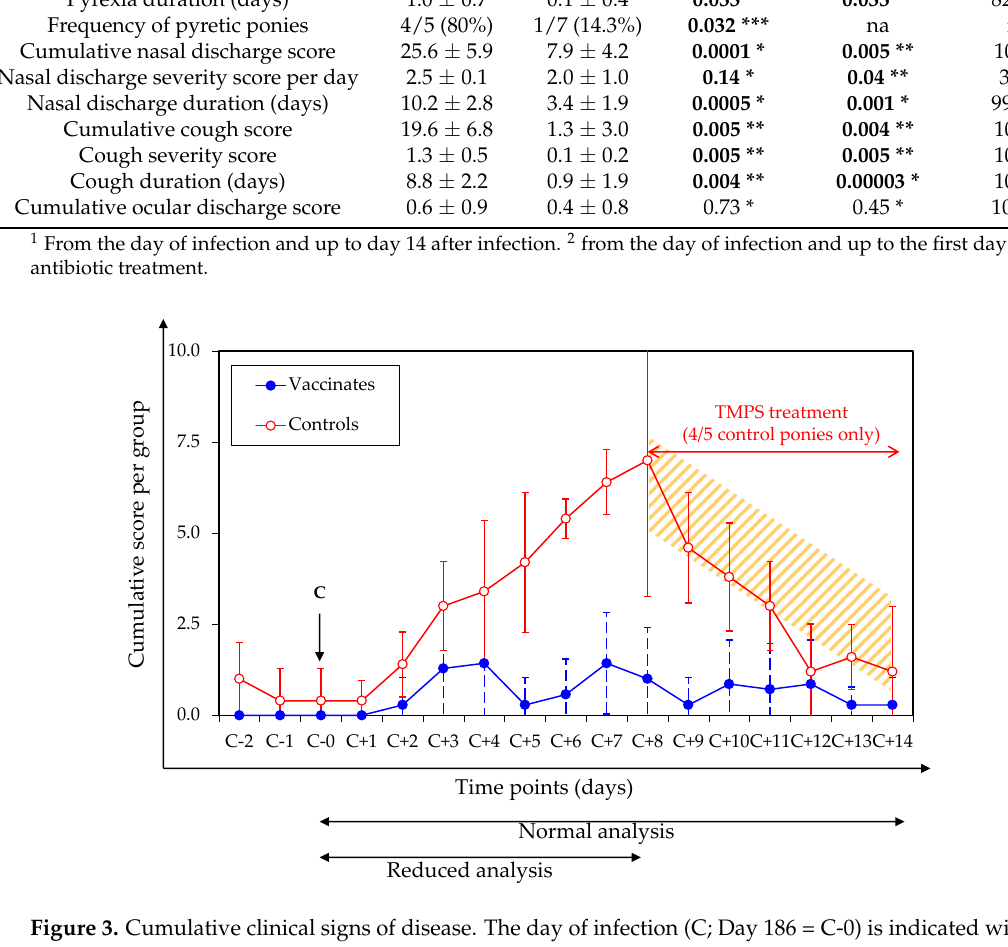
Table 3. Clinical signs (mean ± SD) of disease after experimental infection with A/equine/ Northamptonshire/1/13 and statistical analyses (vaccinated group versus control group). Significant differences are in bold text. Reduction (%, SD) = the reduction in clinical signs in the vaccinated group compared to the control group, A = analysis, S power = statistical power. * Student’s t -test; ** Wilcoxon’s test; *** Barnard’s test.